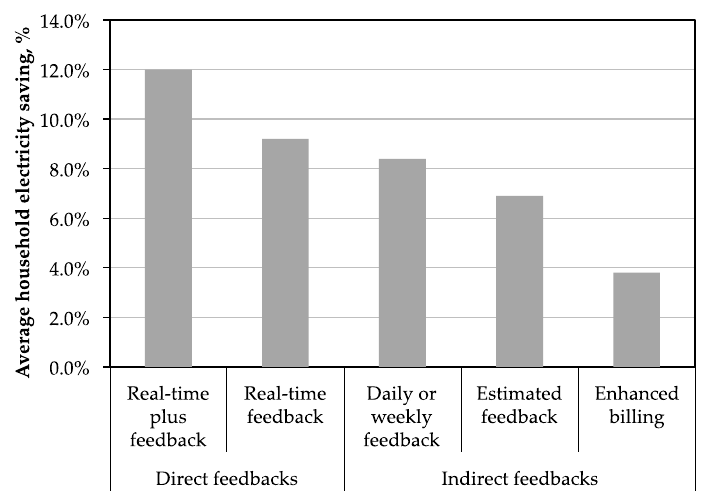
Figure 1. Average household electricity savings disaggregated by feedback type. Modified from reference [42].